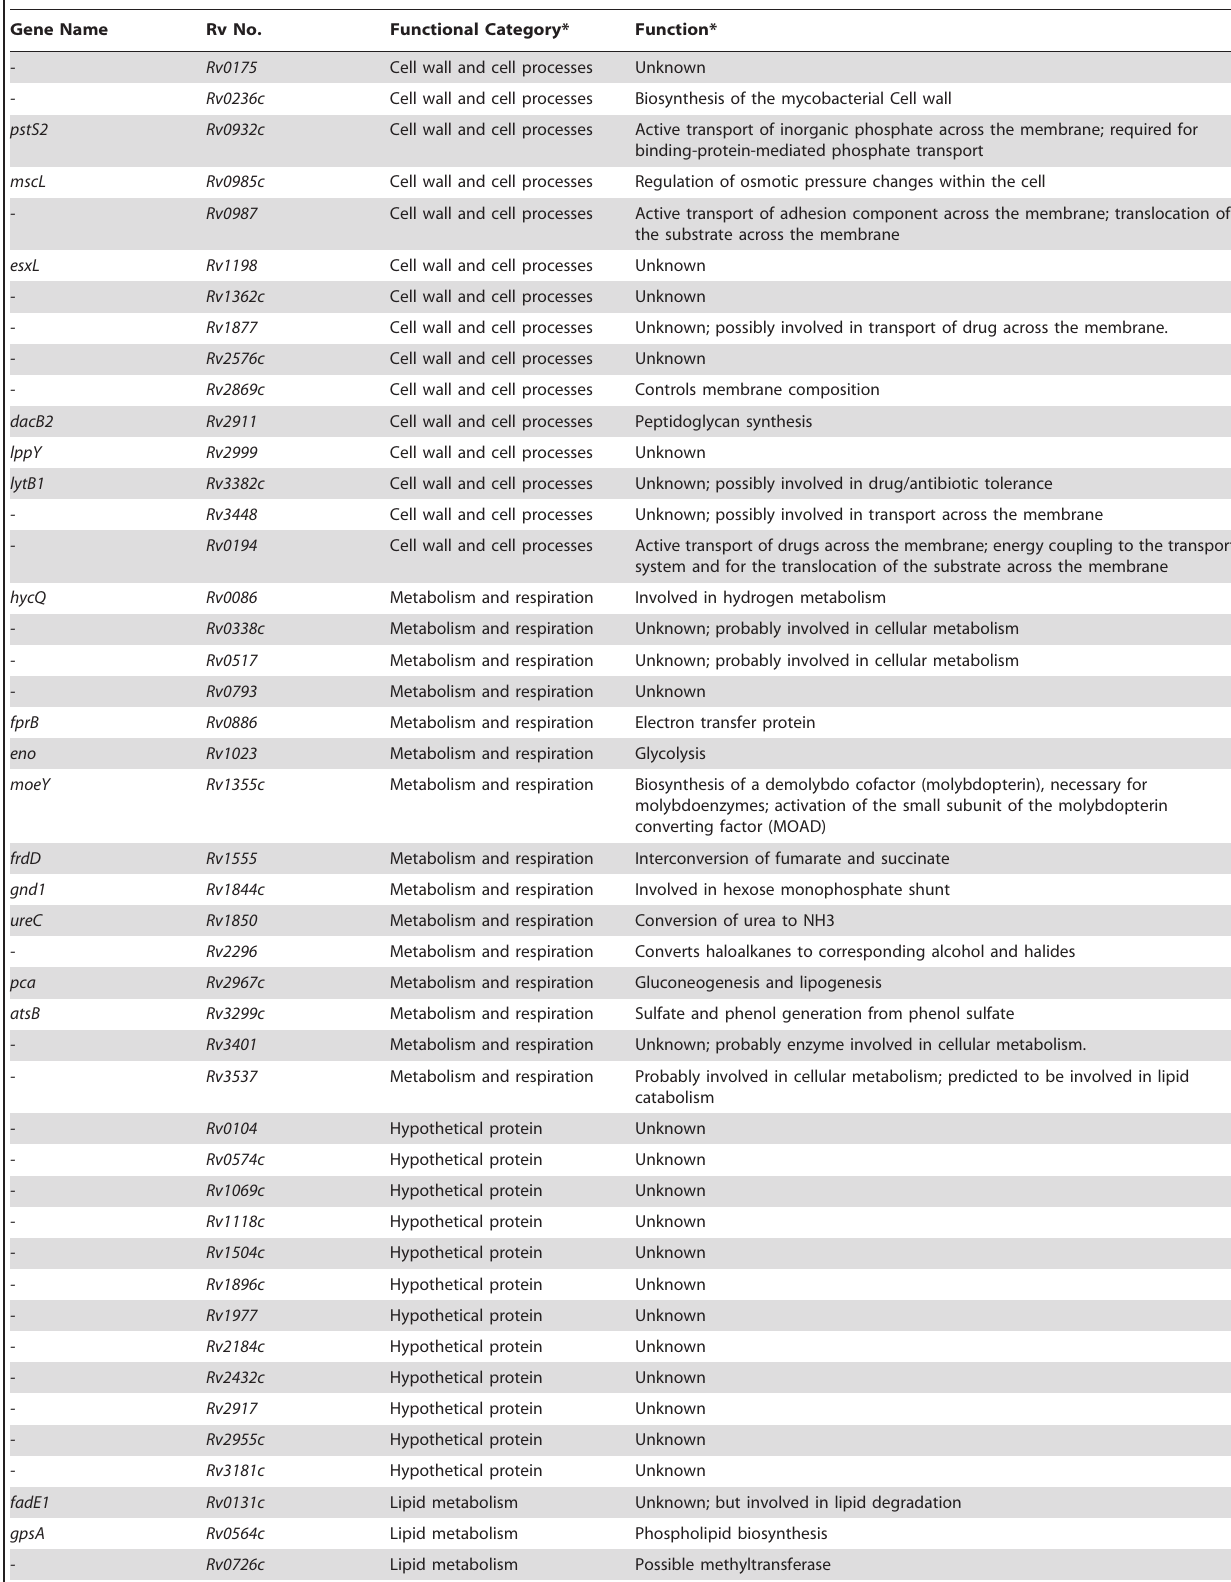
Table 2. Genes and intergenic regions potentially associated with INH-resistance in M. tuberculosis